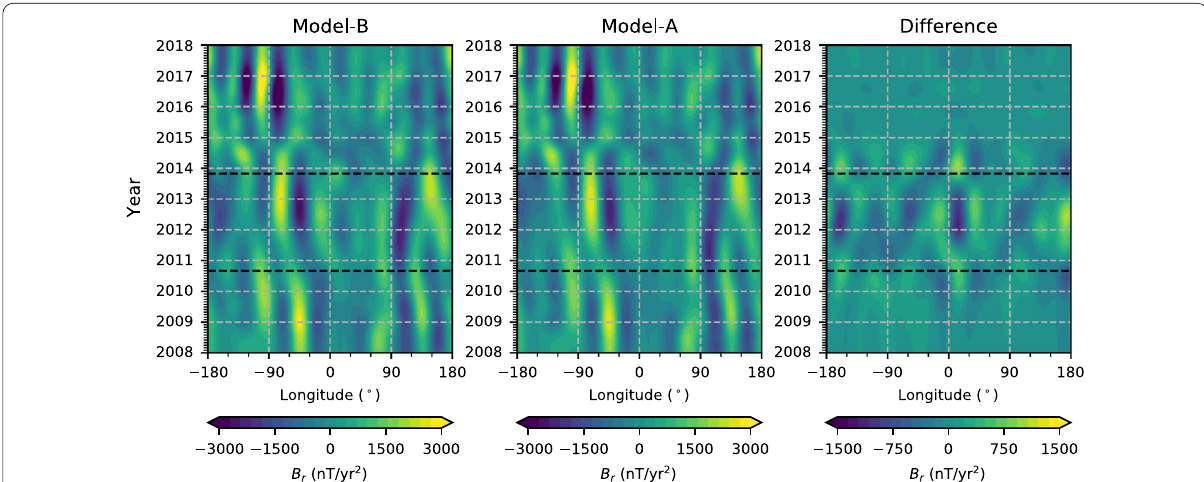
Fig. 9 Time-longitude maps of the radial SA up to degree 10 on the Equator at the CMB as computed with Model-B (left), Model-A (center) and their difference, Model-B minus Model-A (right). The gap period between CHAMP and Swarm is in between the black dashed lines (Sep 2010–Nov